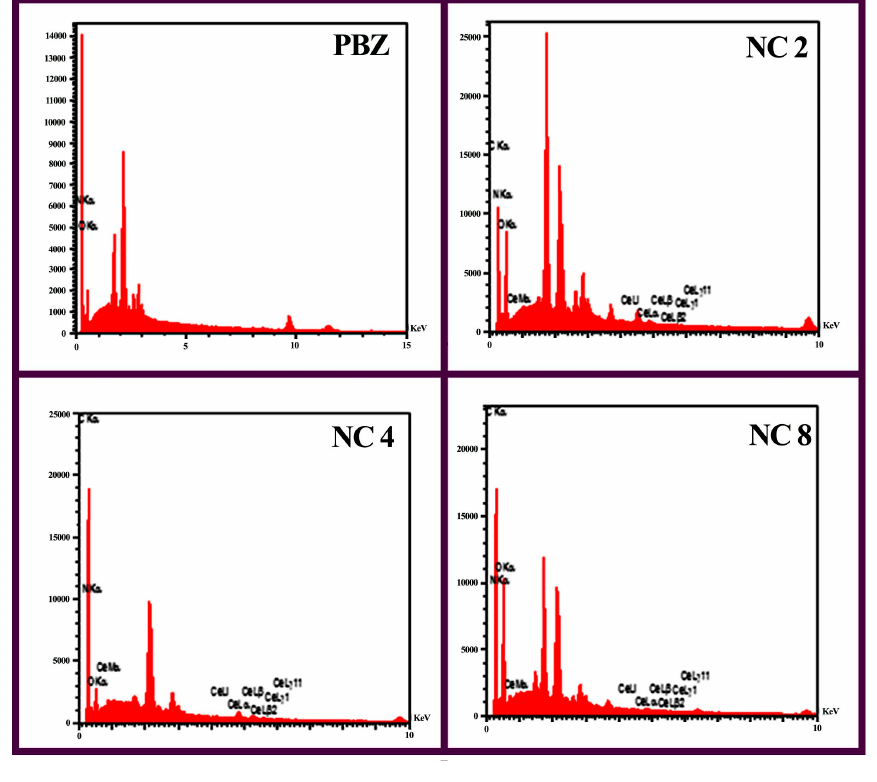
Figure 12. EDS graph of NCs samples.